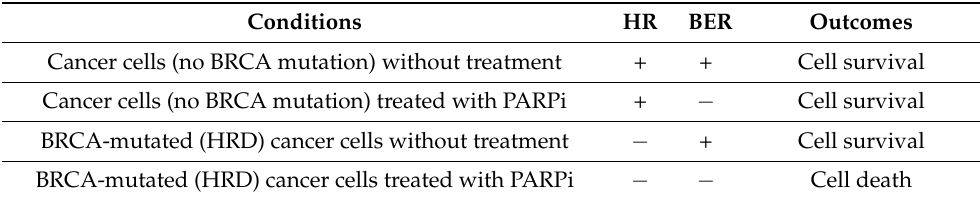
Table 1. The presence or deficiency of HR and BER on the outcomes of normal or BRCA 1/2 mutated cells treated with/without PARP inhibitors. Conditions HR BER